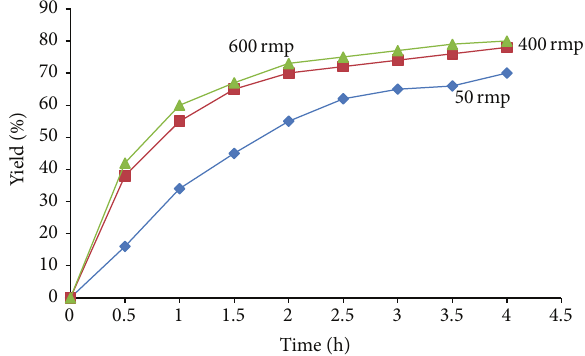
Figure 12: The effect of stirring speed on the efficiency in reaction conditions, 196 ∘ C, PET:catalyst = 100 :1